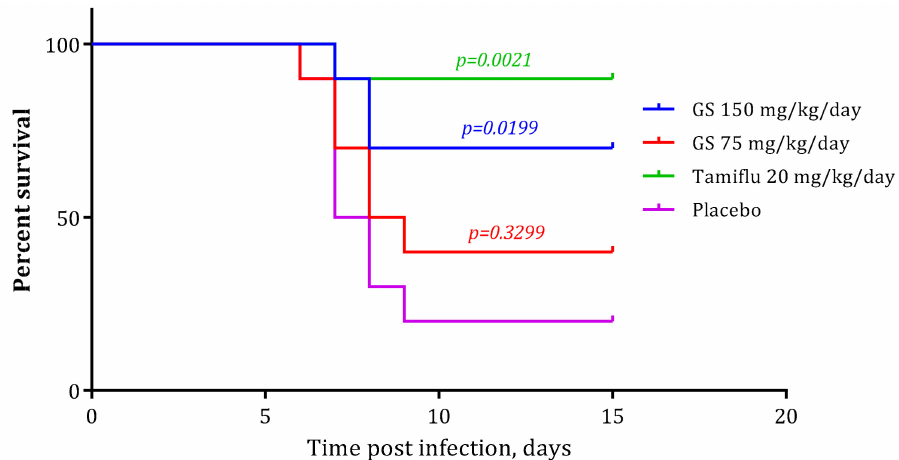
Figure 7. Dynamics of mortality of mice in the course of pneumonia caused by influenza virus A/Puerto Rico/8/34 (H1N1). Animals were infected intranasally with 2.5 × 10 4 pfu of the virus per mouse and monitored for 15 days post-infection. GS was applied orally once a day at days − 1, 0, 1, 2, 3, 4, and 5 post-infection. Log-rank test for comparison with A/PR/8/34 (H1N1)-infected